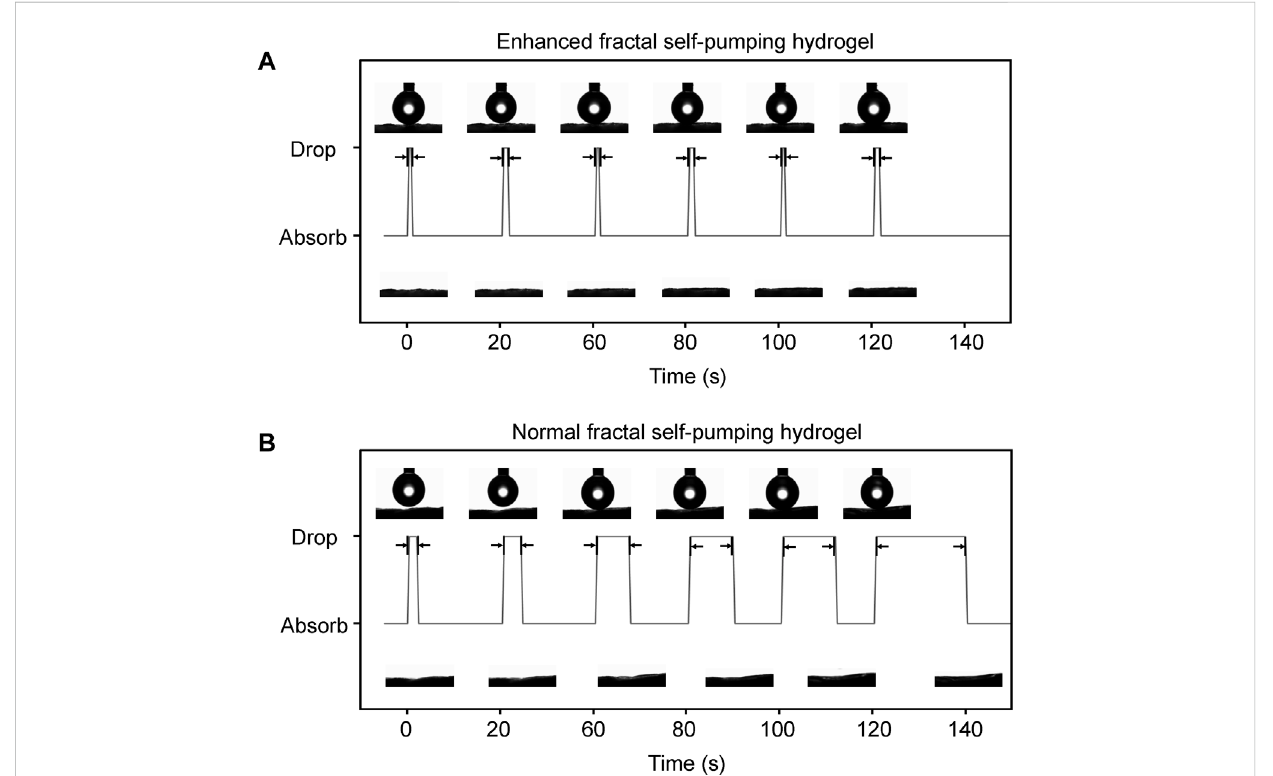
FIGURE 2 Comparison of the continuous absorption performance of the EFS hydrogel (A) with enhanced fractal microchannels and the normal fractal self- pumping hydrogel (B) without enhanced fractal microchannels.